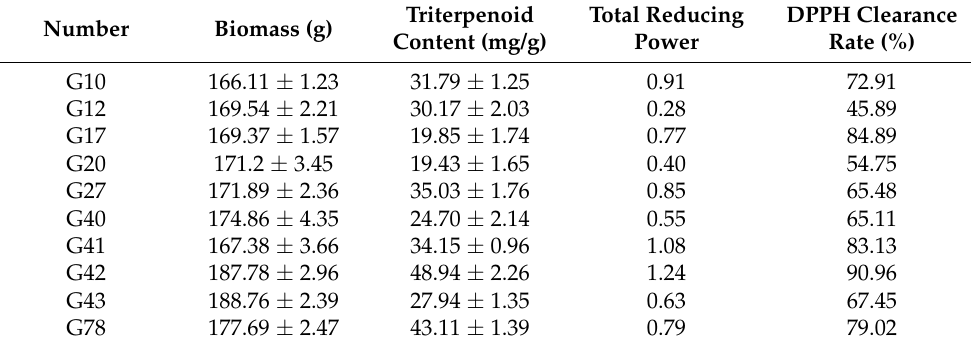
Table 1. Evaluation of SSF of G. tsugae and G. sichuanense